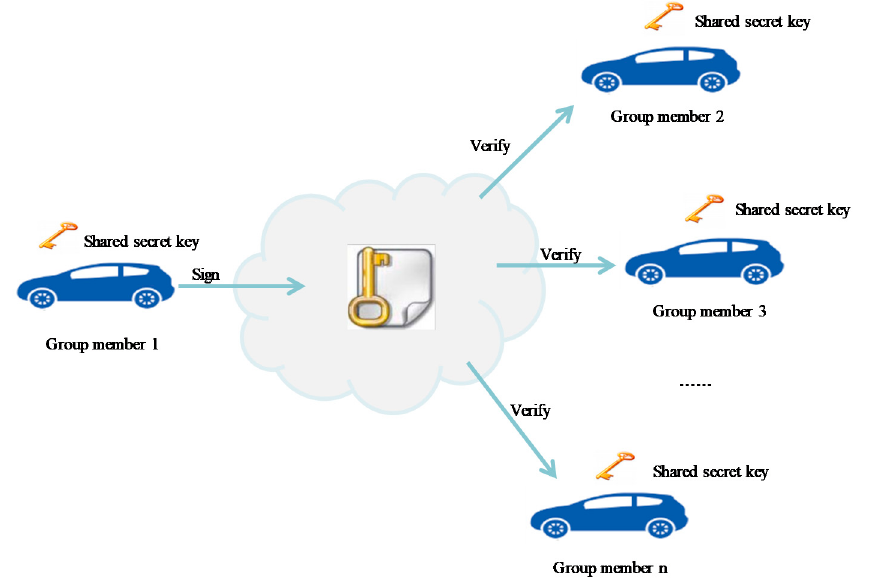
Figure 1. Conventional shared key management method.